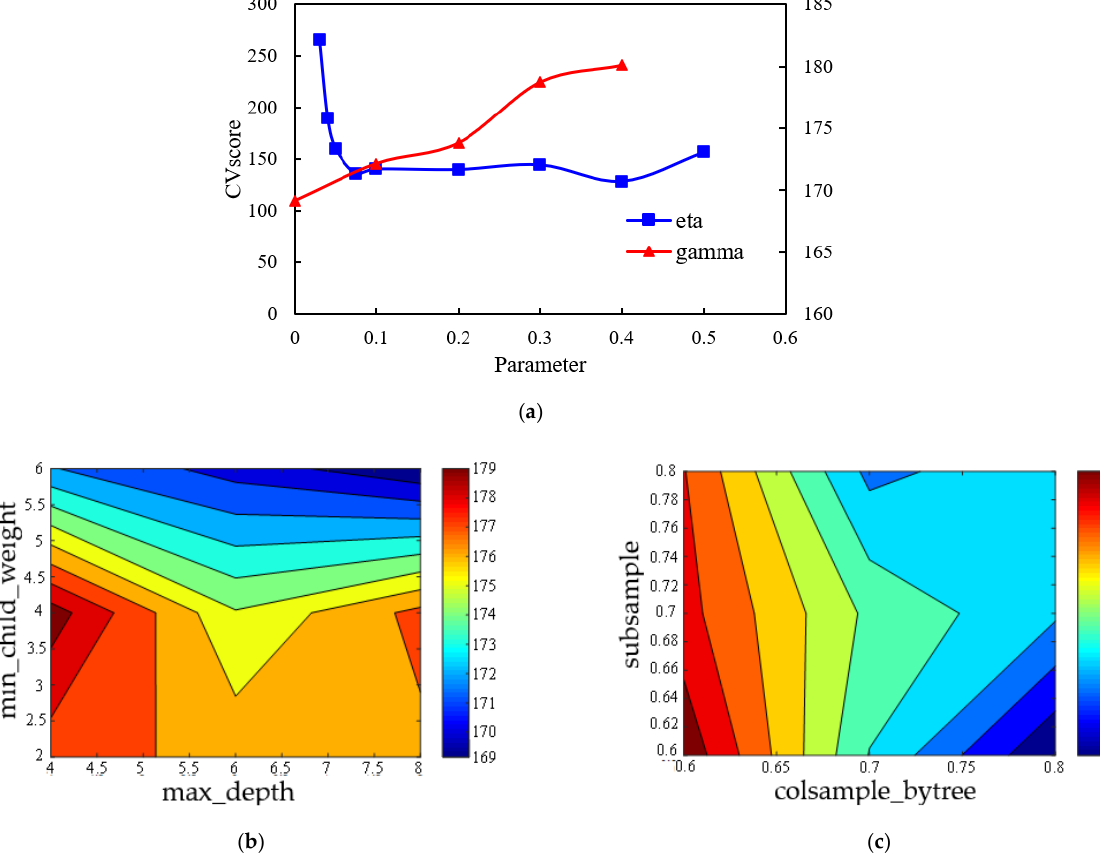
Figure 6. XGBoost regression algorithm to optimize the parameter adjustment process: ( a ) eta and gamma parameter optimization; ( b ) max_depth and min_child_weight parameter optimization; ( c ) colsample_bytree and subsample parameter optimization.